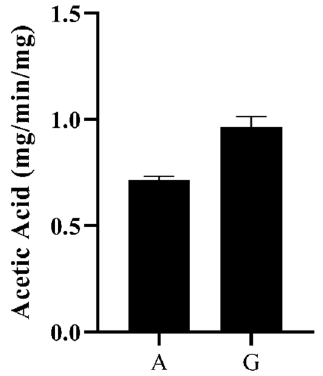
Figure 7. Acetic acid release. The activity of the enzyme on acetylated monosaccharides and xylooligosaccharides was determined by the hydrolytic release of acetic acid from these substrates. Acetic acid release was measured with GC–MS after incubating the enzyme with birchwood xylan (partially acetylated) (A) and β - D -glucosepentaacetate (G). The acetic acid release was estimated from an acetic acid standard plot.